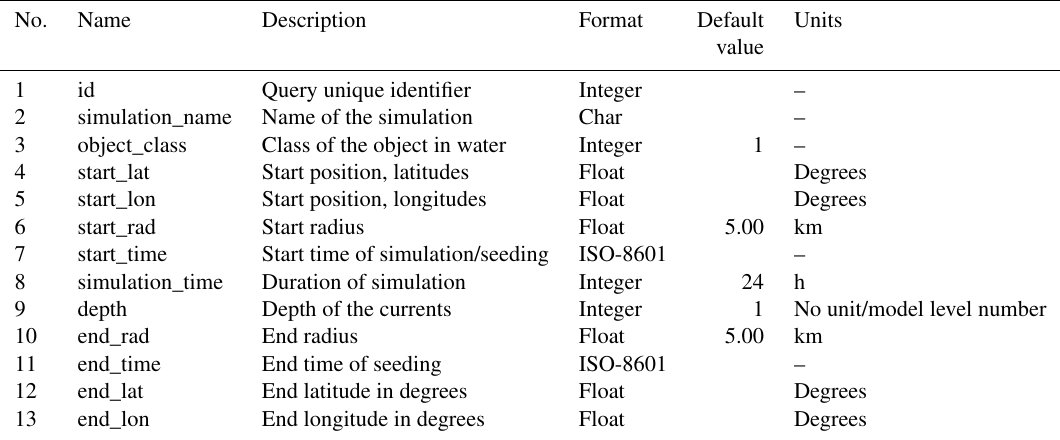
Table A1. Description of user-defined parameters. The data are sorted according to name of parameter as written in the input string, descrip- tion, value type and